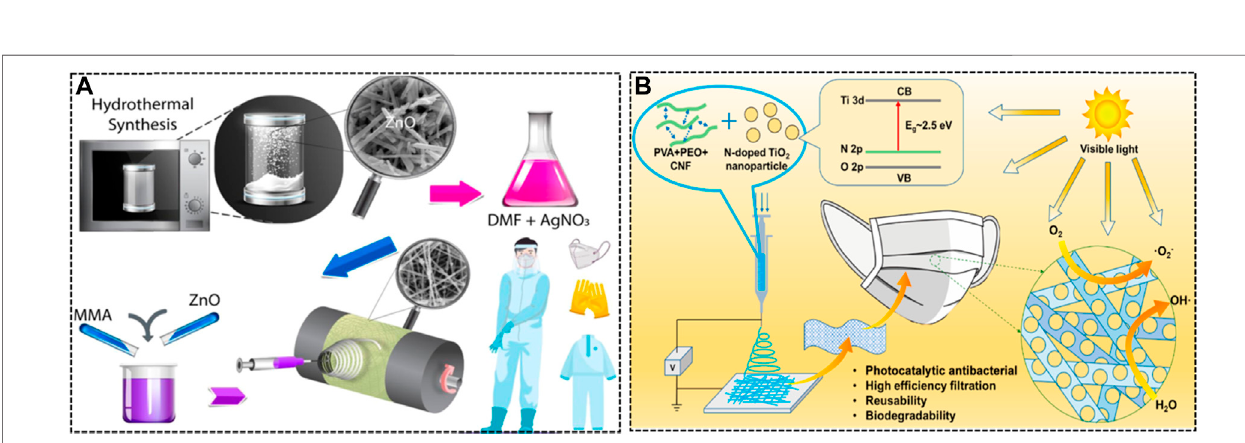
FIGURE1| Electrospunnano fi berswabsfordetectionofSARS-CoV-2andotherbiologicalspecimens. (A) Thefabricationprocessofnano fi berswabtips; (B) The microstructures of the nano fi ber swabs and their usage method [Adapted with permission from (McCarthy et al., 2021). Copyright (2021) American Chemical Society].